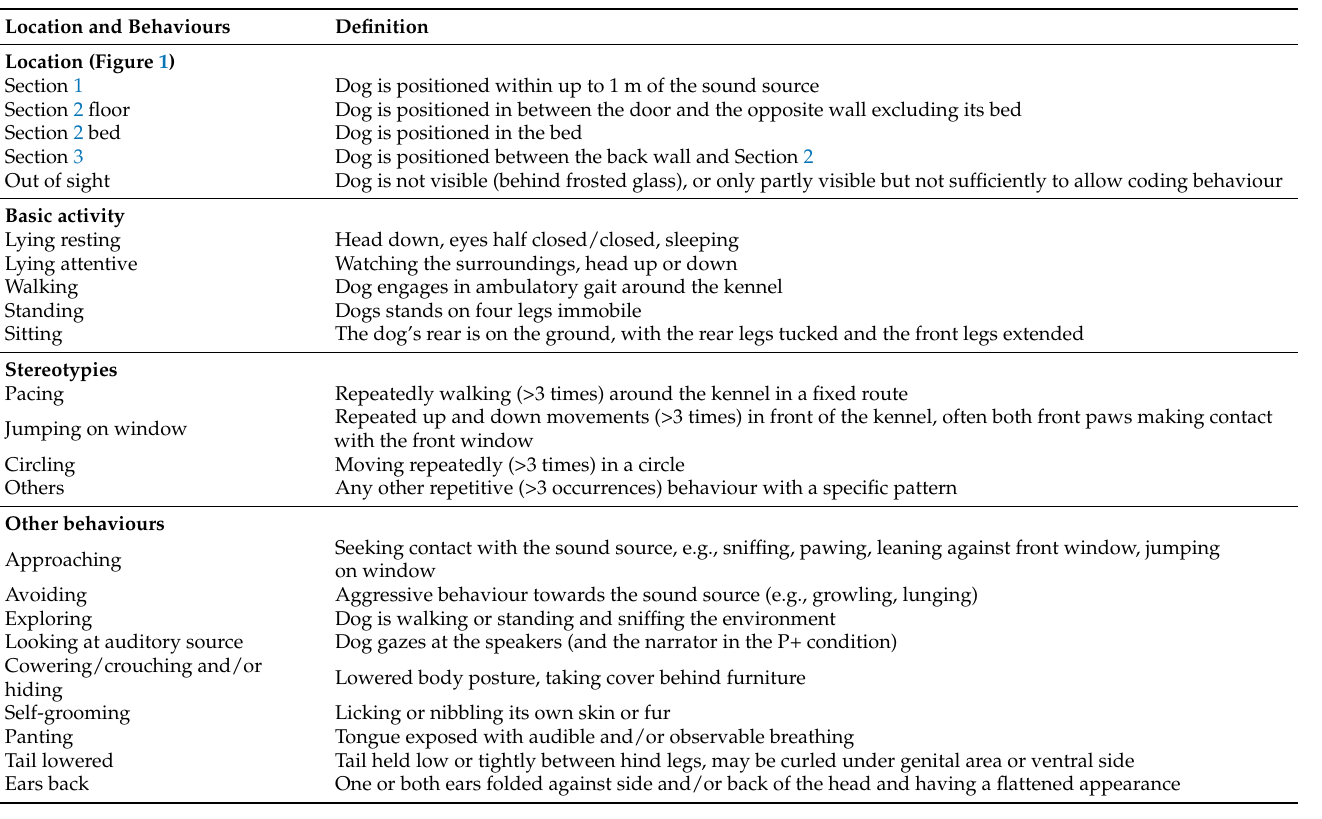
Table 1. Ethogram to record the dogs’ behaviour: location, basic activity, stereotypies and other behaviours. Behaviours were adapted from